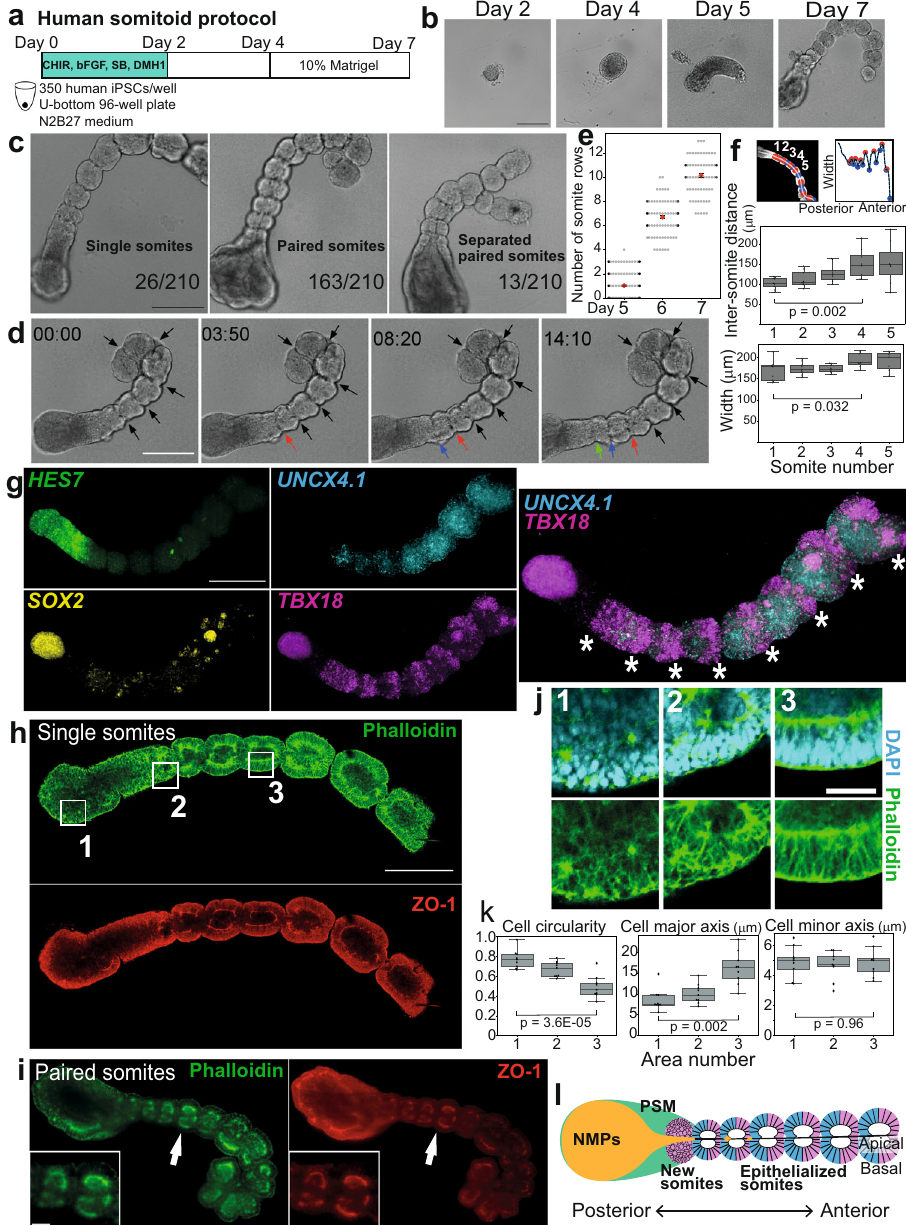
Fig. 1 Generation and characterization of human somitoids. a Somitoid protocol. 350 human iPSCs were aggregated in a U-bottom plate and treated